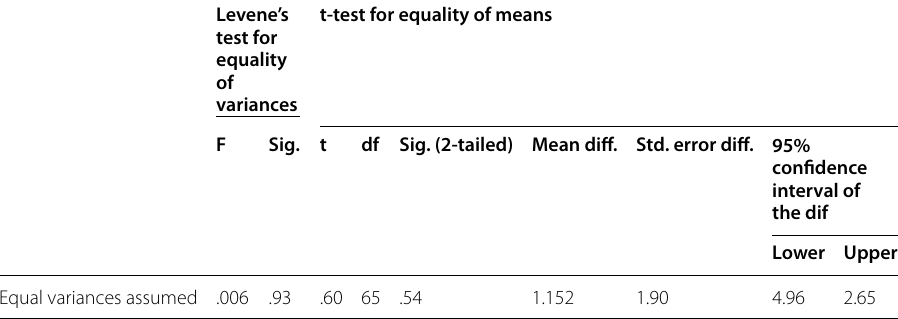
Table 6 Independent samples T-test between ectenic and synoptic learners in EI group, posttest